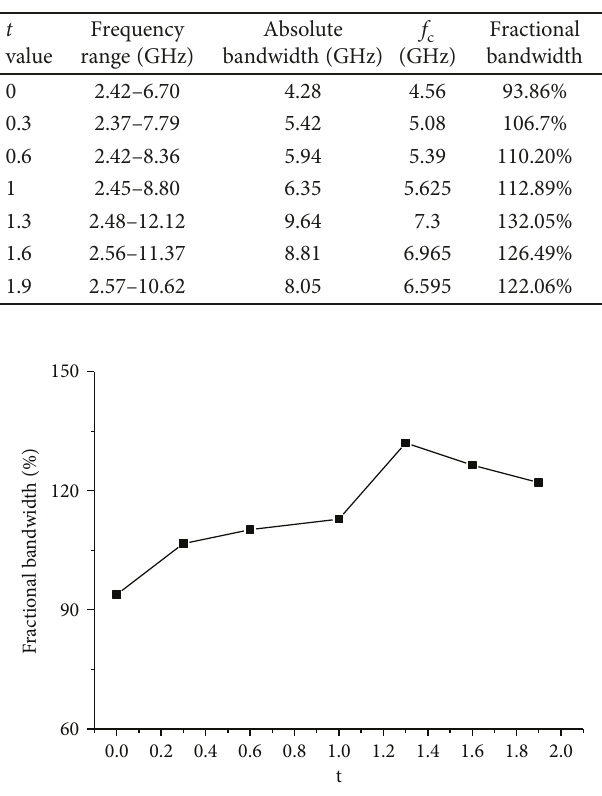
Figure 7: Antenna impedance bandwidths versus t